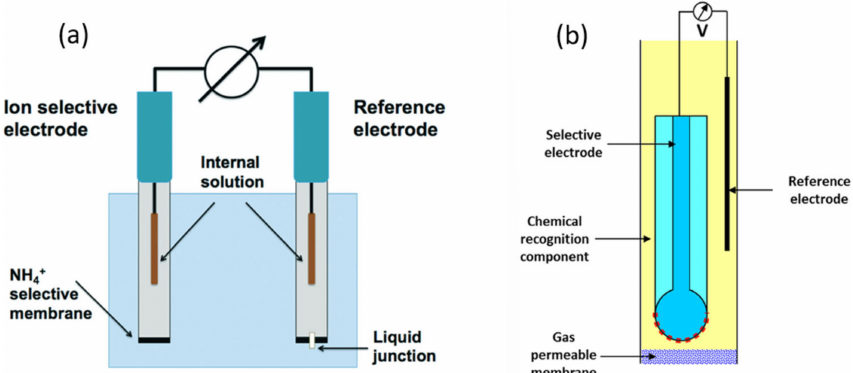
Figure 6. Schematic diagram of ( a ) NH 4 + ion selective electrode. Adapted with permission from Ref. [57] Copyright 2019, Royal Society of Chemistry. ( b ) A typical membrane-based electrochemical gas sensor. For the ammonia gas sensing electrode, the pH electrode is typically used as a selective electrode. Adapted from Ref. [58] Copyright 2017,